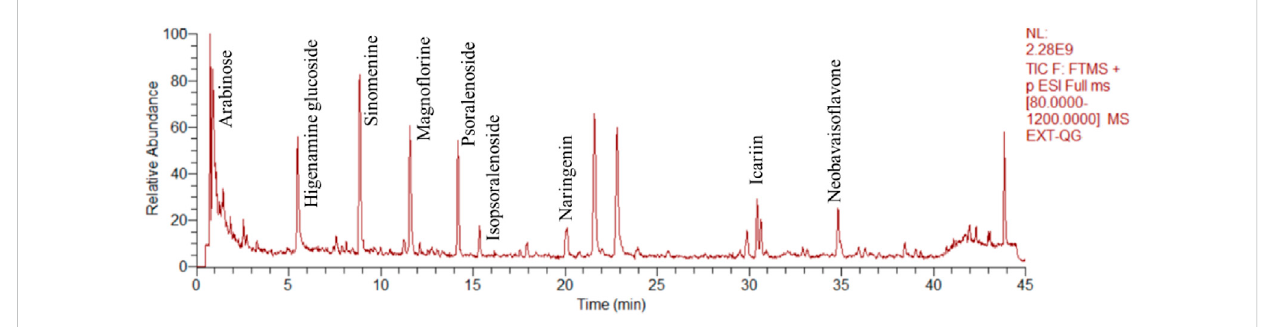
FIGURE 2 Total ion chromatograms of JBQG in UHPLC-Q-Orbitrap HRMS negative mode and positive mode were